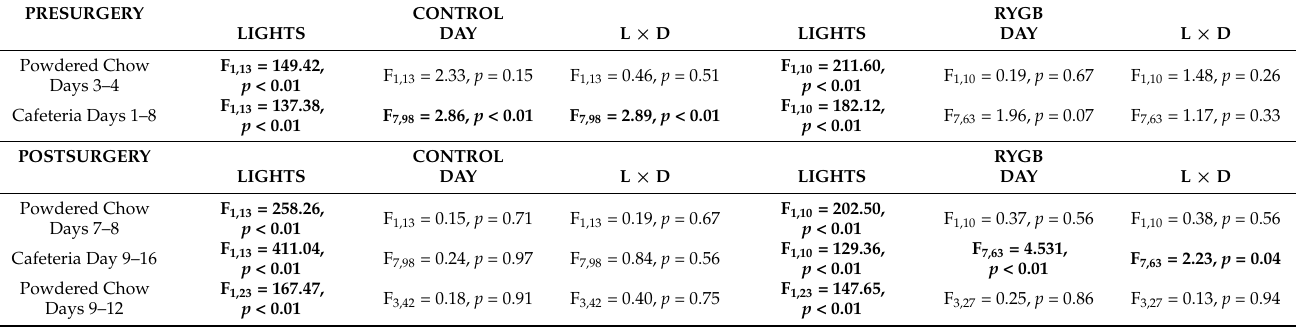
Table 17. Two-way ANOVAs Comparing Lights-On to Lights-Off Meal Number within Groups for Each Diet